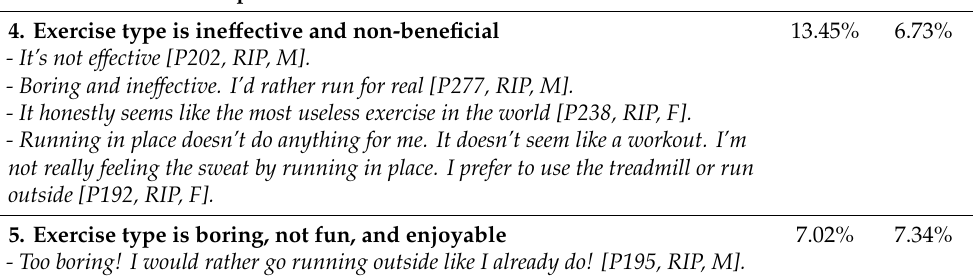
Participants’ Comments based on